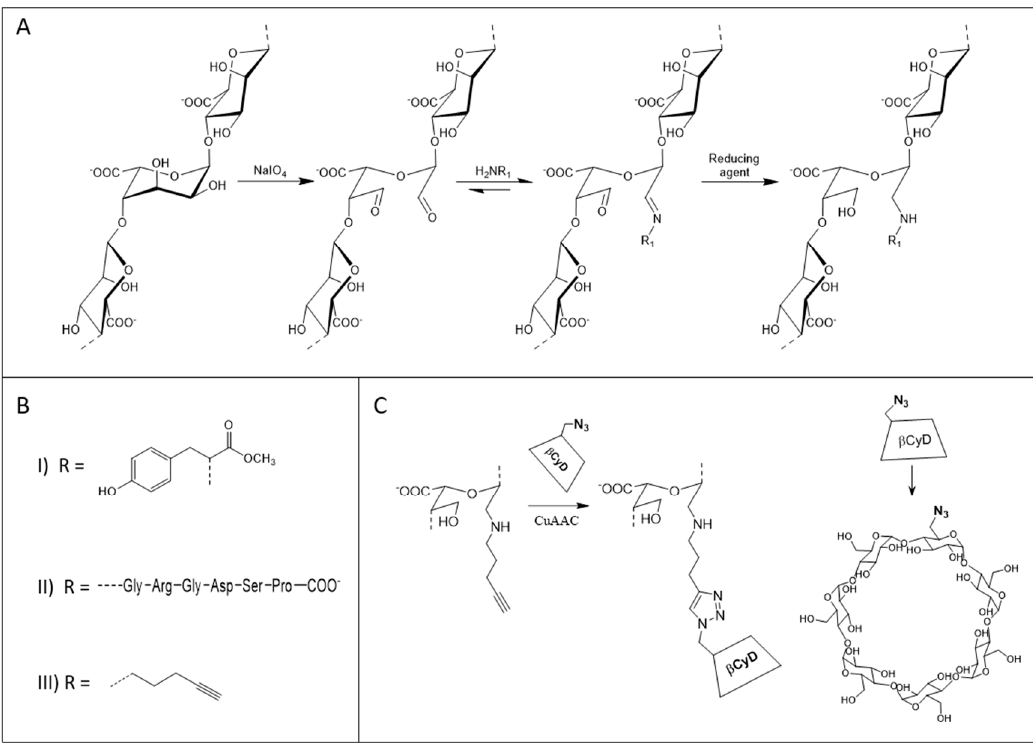
Figure 1. ( A ): General reaction scheme for periodate oxidation (step 1) followed by reductive amination (step 2 and 3) of alginate (here represented by an MGM-fragment). ( B ): Structure of the different substituents grafted onto alginate by reductive amination. I: L -methyl tyrosine ester (MeOTyr), II: the hexapeptide GRGDSP, III: 4-pentyn-amine, used as a linker for further grafting of β -cyclodextrin ( β -CyD). ( C ): Grafting of β -CyD to pentyn-amine linked alginate via the copper catalyzed azide alkyne cycloaddition click-reaction. The scaling of alginate and β -CyD is not similar. Table 1. Characterization of the functionalized alginates in this study: P 0 = mole periodate per mole uronate residue), degree of substitution (DS, mole substituent per mole uronate residue%), average